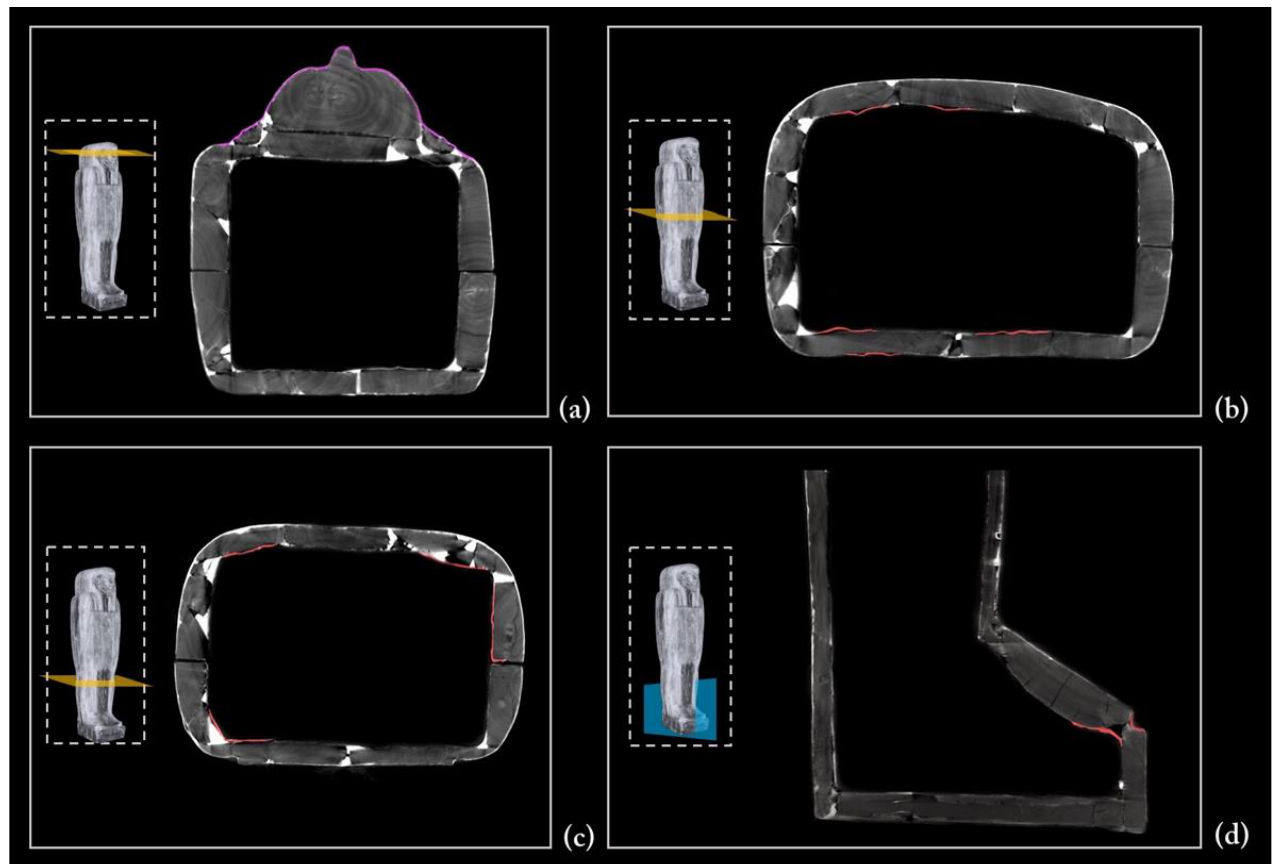
Figure 17. ( a ) The incamottatura covering face and ears (highlighted in pink); ( b – d ) a few examples of the incamottatura no longer adhering to the wooden planking surface (highlighted in red).